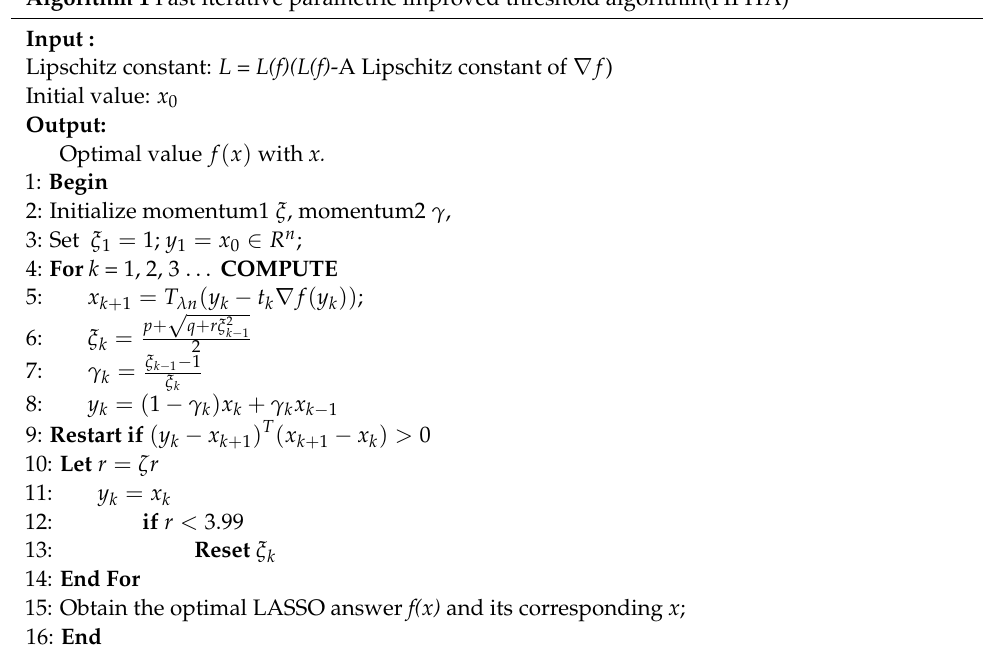
Algorithm 1 Fast iterative parametric improved threshold